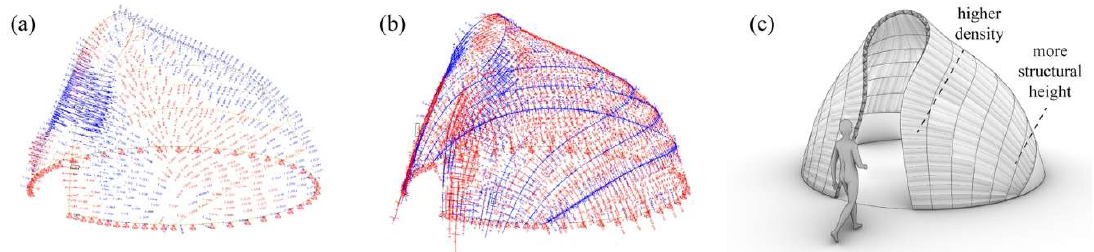
Figure 17. Analyzing ( a ) the deflections and ( b ) stress distribution of the shell informs ( c ) the design of the sandwich structure and affects parameters like the corrugation density and structural height.